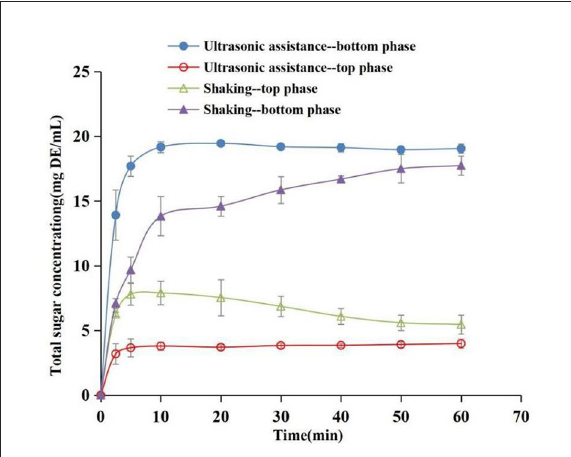
FIGURE9 Concentration evolution of total sugars as a function of time in top phase and bottom phase (Extraction conditions: sonication: 30 ◦ C and 96.1 W/L; shaking: 30 ◦ C and 100